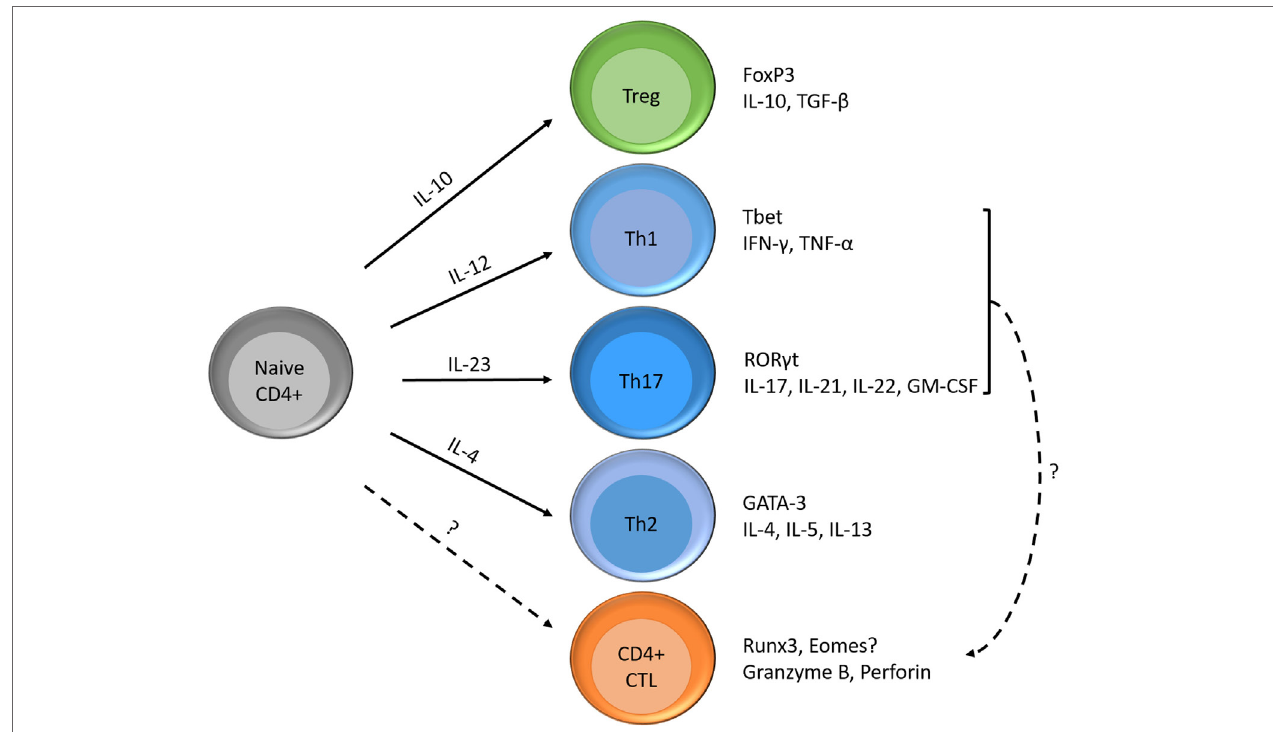
FiGUre 2 | Differentiation possibilities of naïve CD4 + T cells and formation of CD4 + CTLs. Naïve CD4 + T cells can differentiate into T helper cells (e.g., Th1, Th2, and Th17), regulatory T cells and cytotoxic T cells according to the cytokines in their environment. Each subset has its specific transcription factor and produces its signature cytokines. Next to the differentiation of naïve T cells into CD4 + CTLs, Th1, or Th17 cells are also thought to become